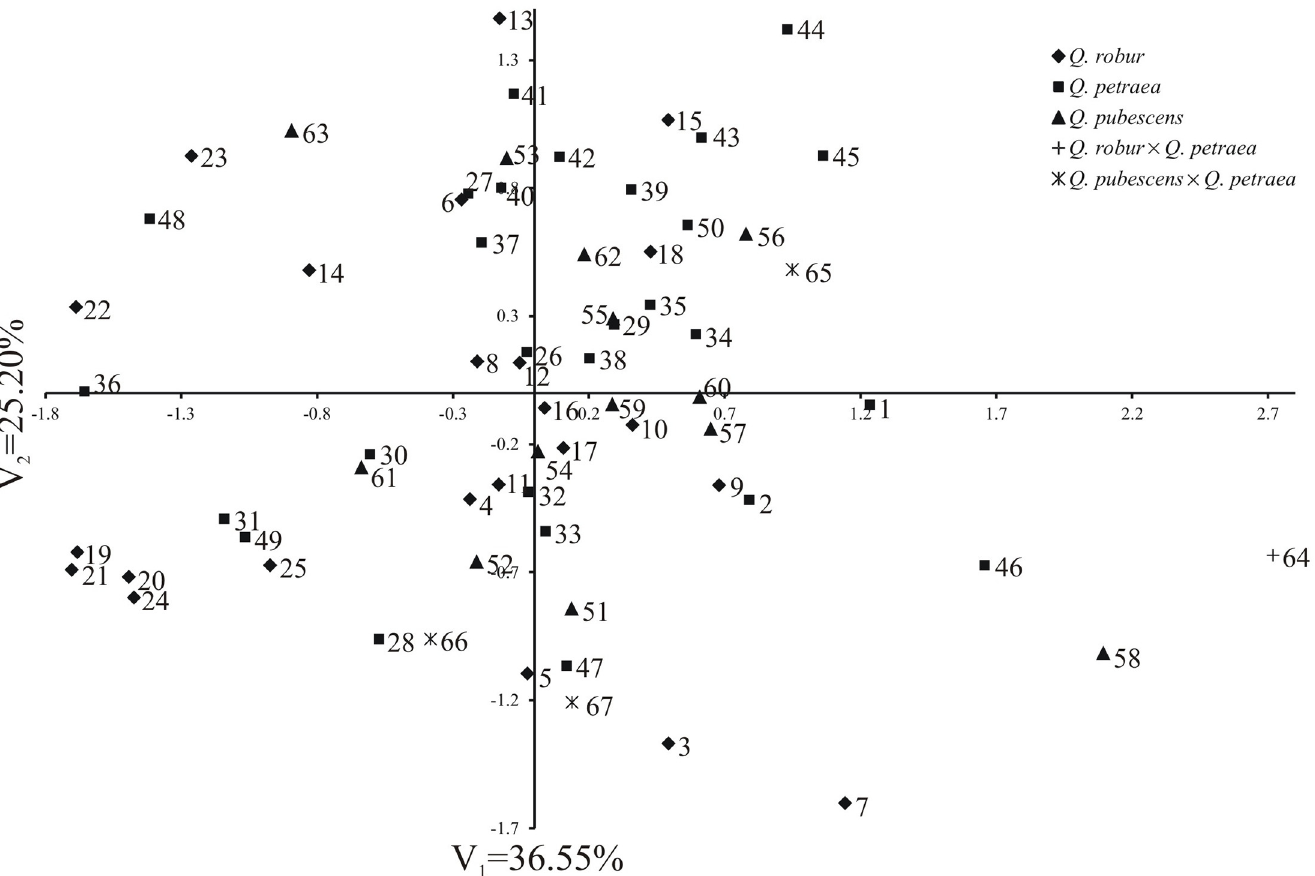
Fig 6. Distribution of 67 Quercus trees studied in the space of two first canonical